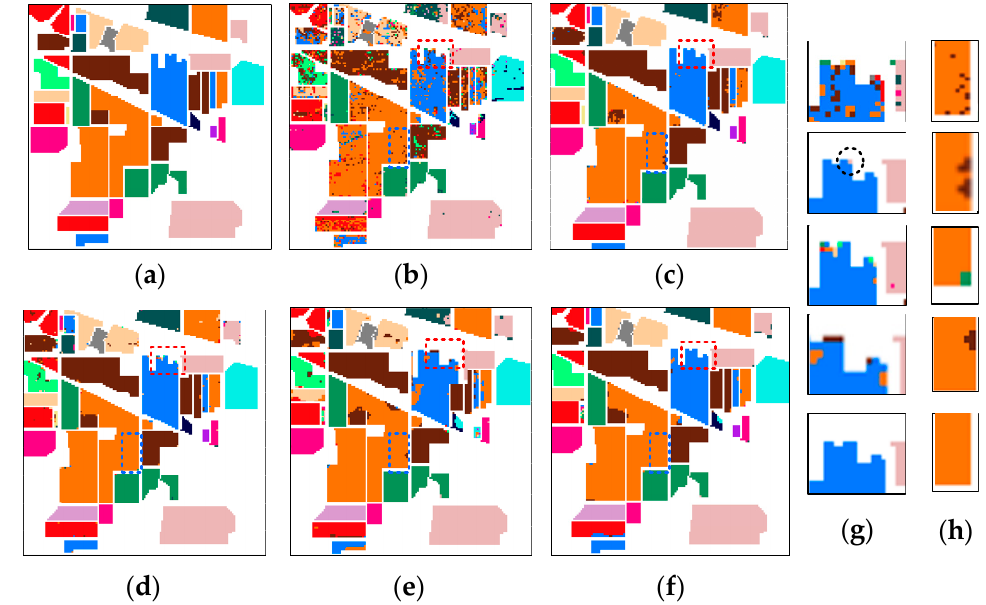
Figure 8. Classification maps from the proposed DANCE-DRCNN method and the baselines on the Indian Pines data: ( a ) ground truth; ( b ) SVM-PCA; ( c ) PCA-CNN; ( d ) 3D-CNN; ( e ) DRCNN; ( f ) DANCE-DRCNN; ( g , h ) enlarged edge image.